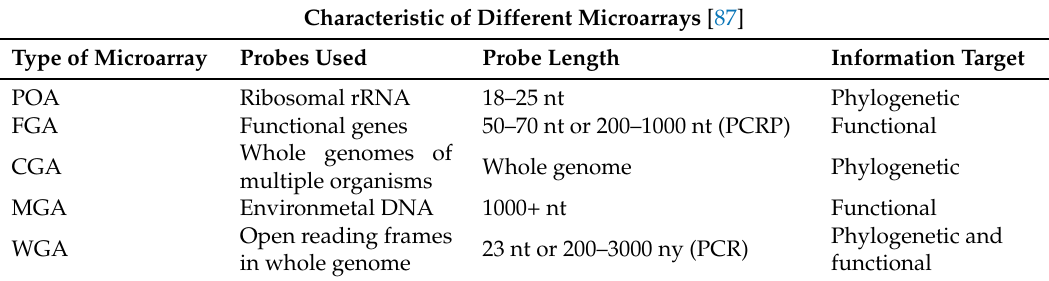
Table 6. Summary of microarray technique